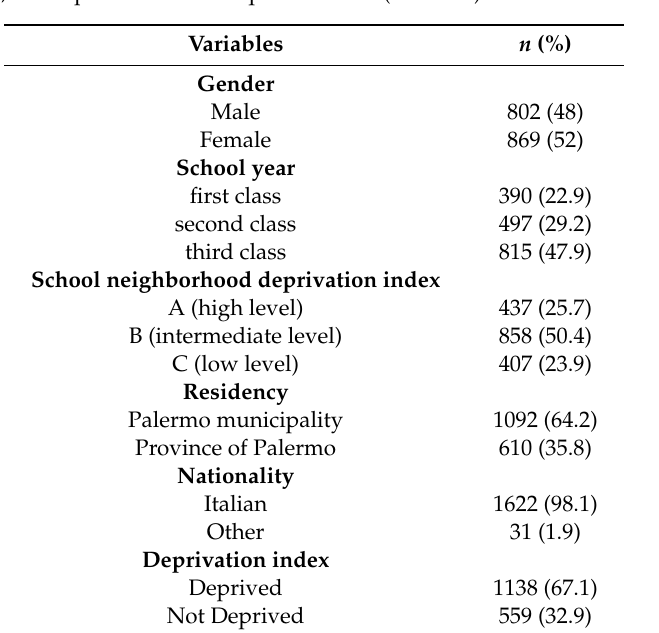
Table 1. Sociodemographic and general characteristics of students enrolled in the first-grade secondary schools of Palermo, in the pre-intervention questionnaire ( n = 1702).